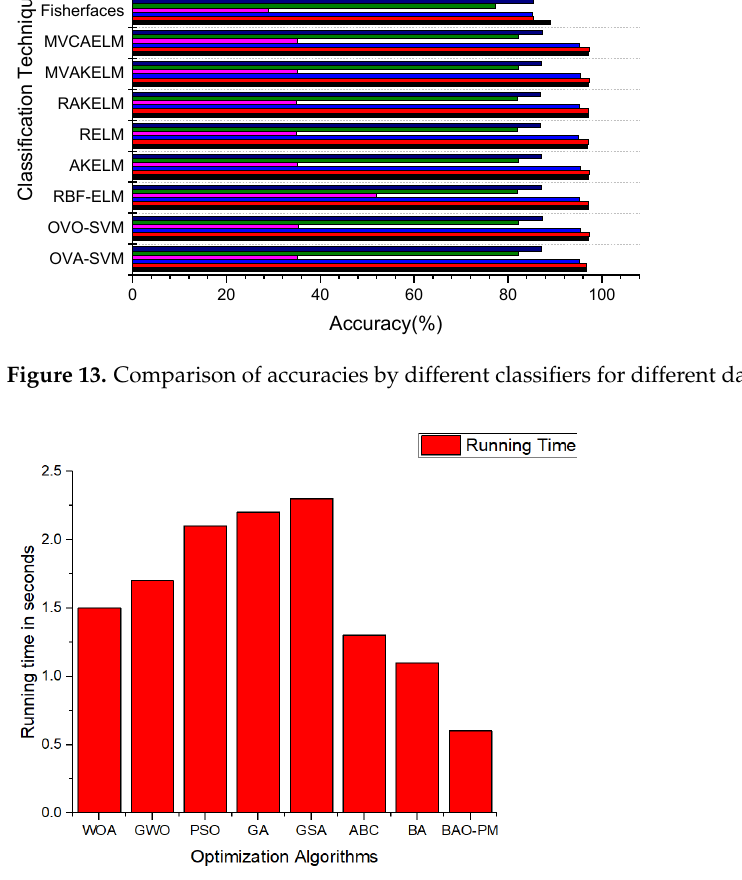
Figure 14. Running time achieved by BAO with PM operator.